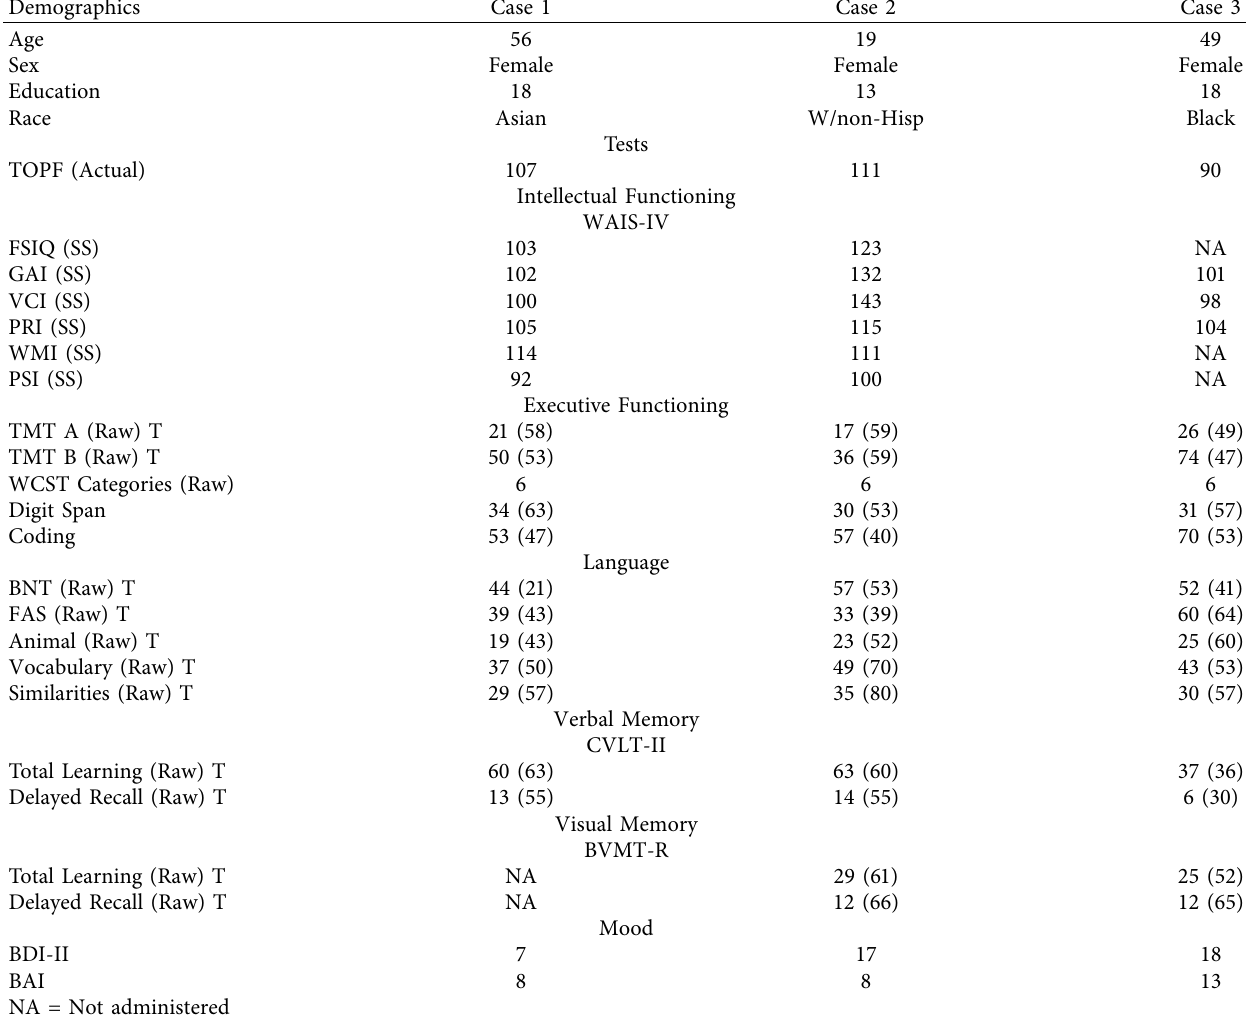
Table 1: Neuropsychological findings in the three cases after recovery from SARS-CoV-2